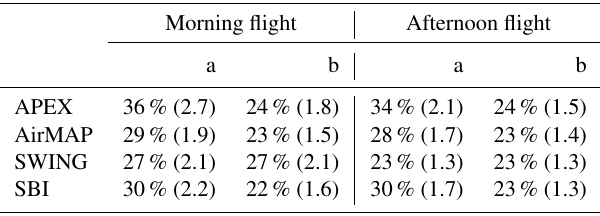
Table 5. Mean NO 2 VCD retrieval errors for the morning and after- noon flights. The mean relative errors (percent) and absolute errors ( × 10 15 moleccm − 2 ) for the retrieved VCDs are provided for (a) the native spatial resolution of the different instruments and (b) the common resolution of 0.0045 ◦ used for the intercomparison